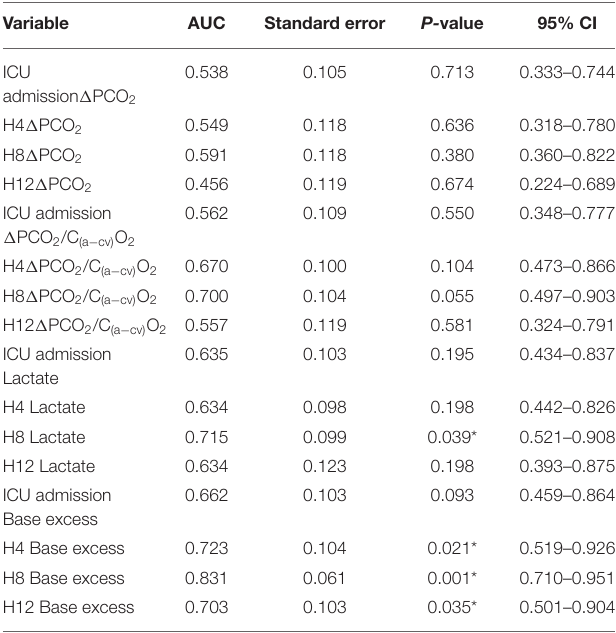
TABLE 4 | Area under the ROC curve of variables grouped into n-OI and